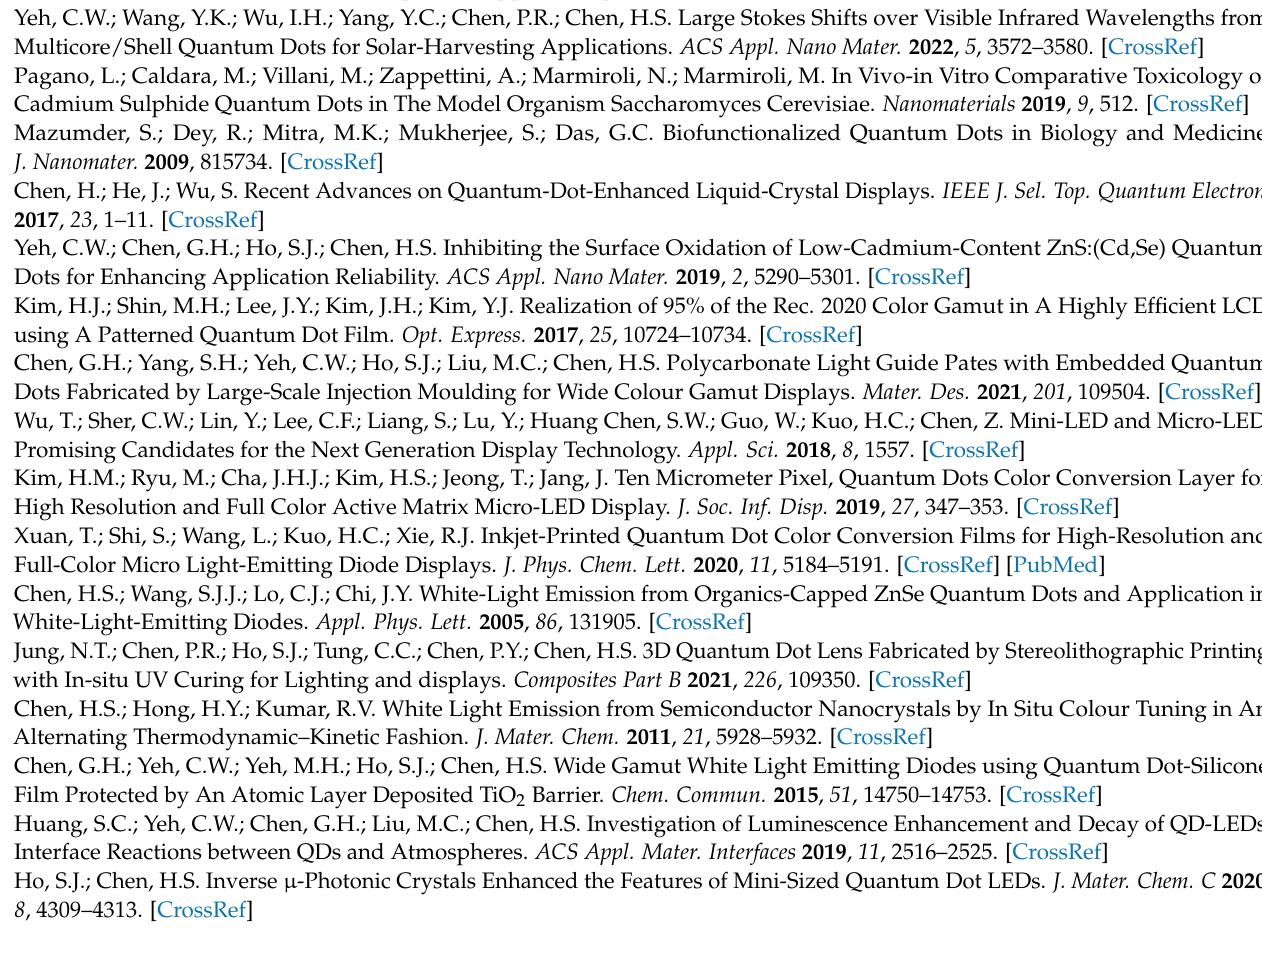
film, Figure S2: UPS spectrum and Tauc plot of the green QDs used in this work, Figure S3: The transmittance spectra and the reflectance spectra of Ag and Ag/capping layer with different ZnO NPs thickness, Figure S4: Current density-voltage-luminance characteristics and (b) Luminance-current efficiency characteristics for the TEQLED devices with or without a capping layer (thickness ~ 30 nm), Figure S5: The cross-sectional SEM images of